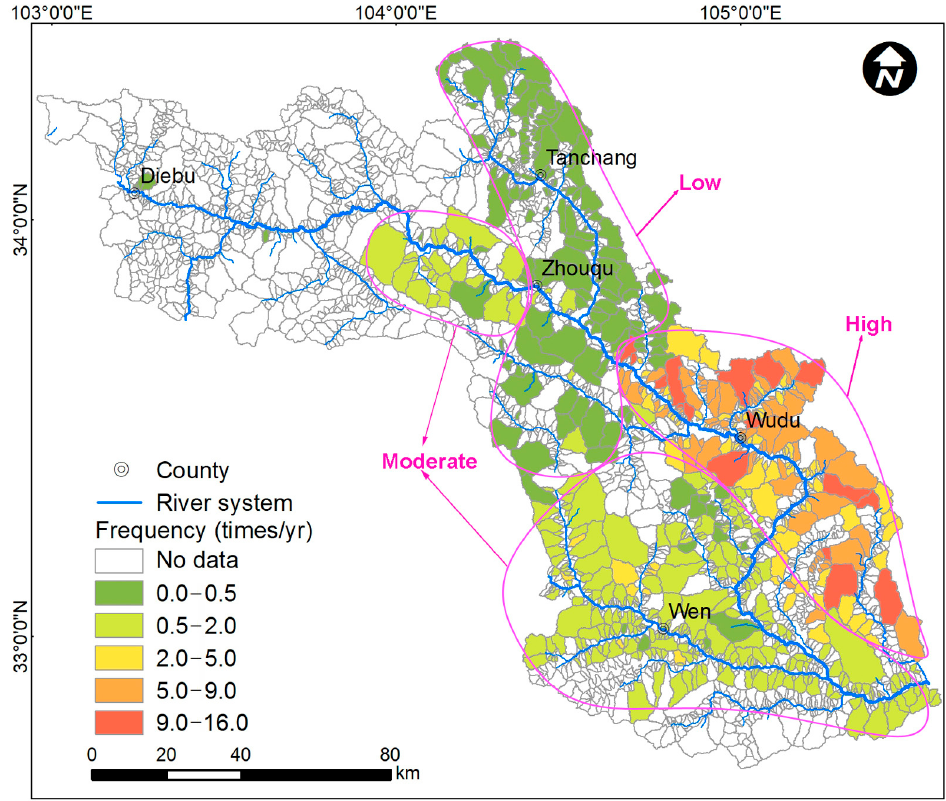
Figure 5. Frequency division results of debris flows in the Bailong River Basin.